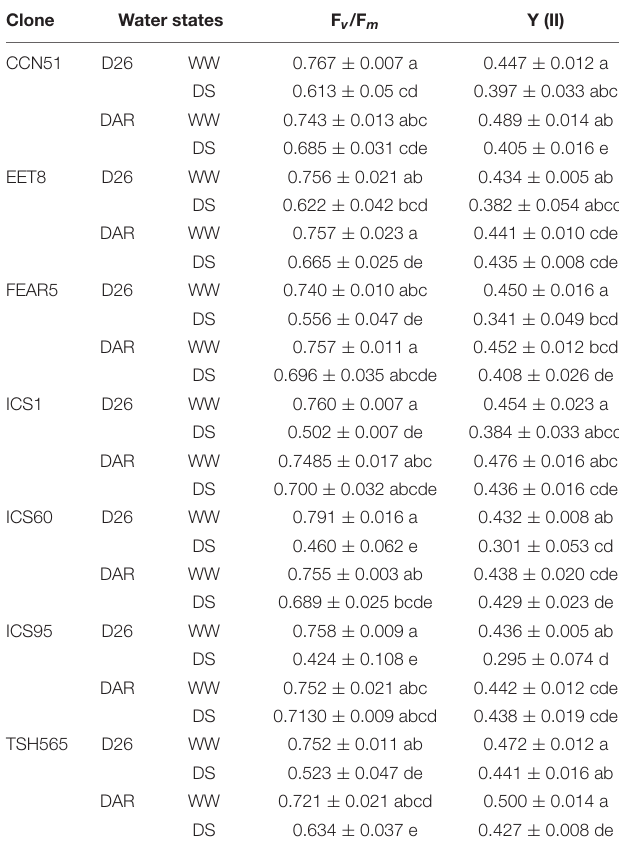
TABLE 6 | Changes in the maximum quantum yield of PSII (F v /F m ) and effective quantum yield of PSII (Y (II)) of cacao clones under different water